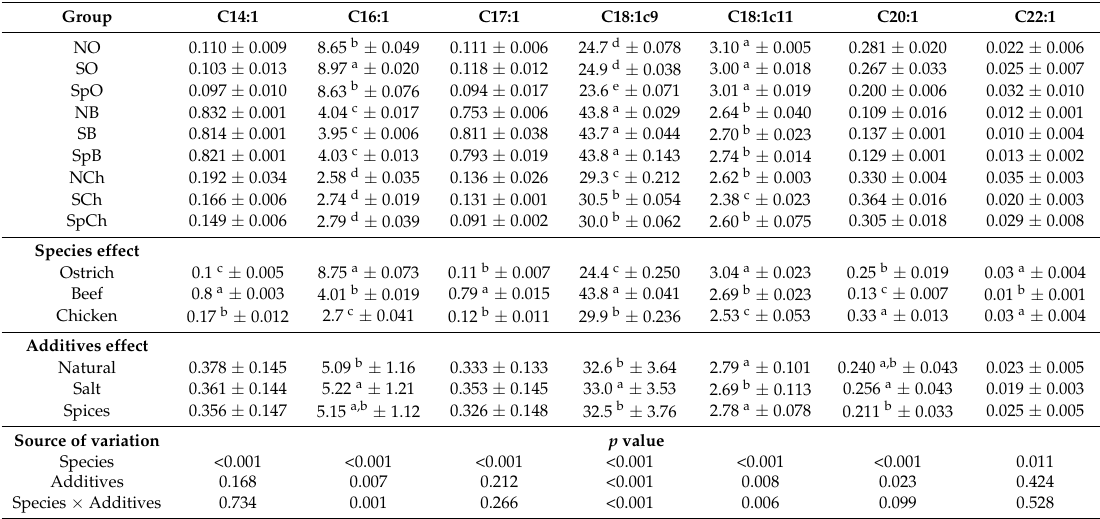
Table 3. Monounsaturated fatty acid composition in dried meat (%) (mean ± SE).